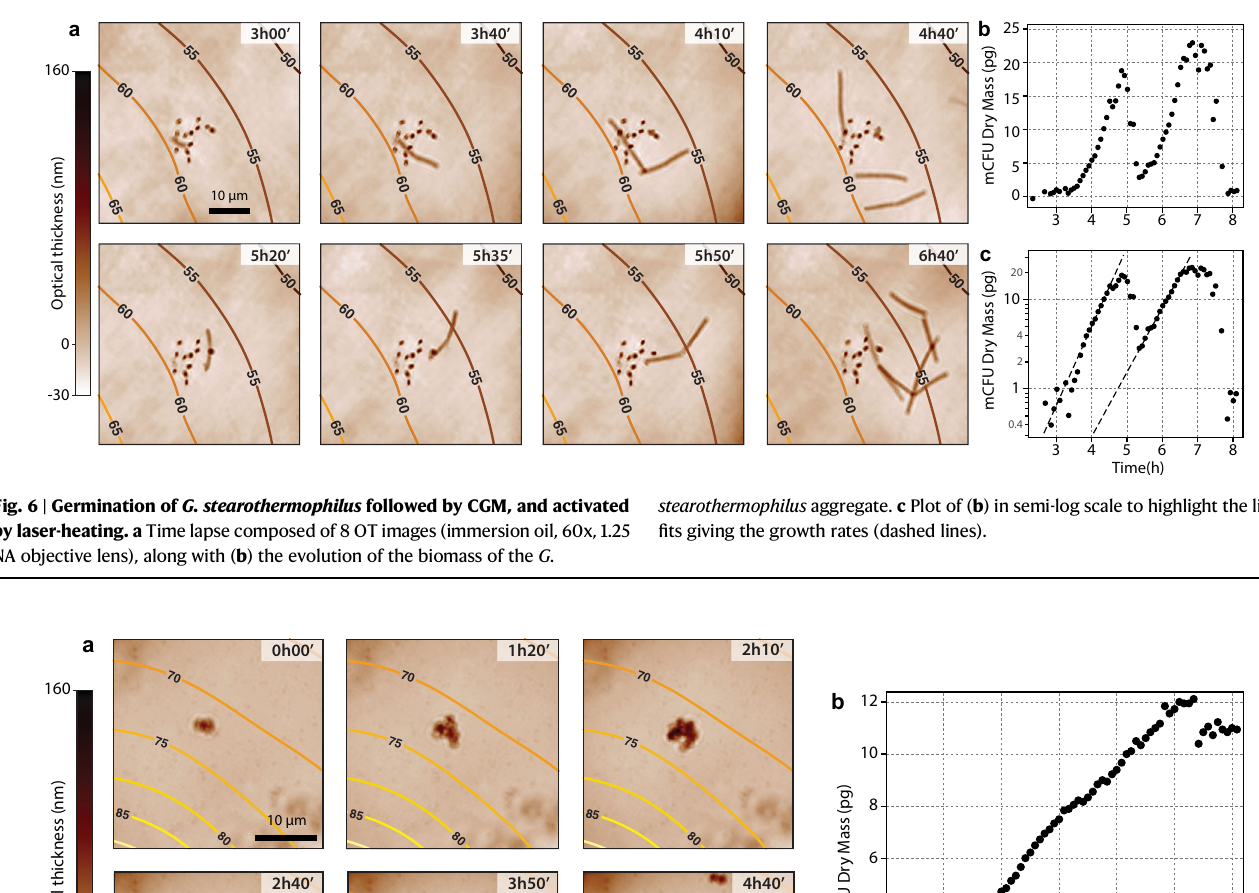
Fig.7 |Growthof S.shibatae archaeafollowedbyCGM,andactivatedbylaser-heating.a Timelapsecomposedof6OTimages(immersionoil,60x,1.25NAobjective lens), along with ( b ) the evolution of the biomass of the microscale CFU measured by CGM. See Movie M7 in Supplementary